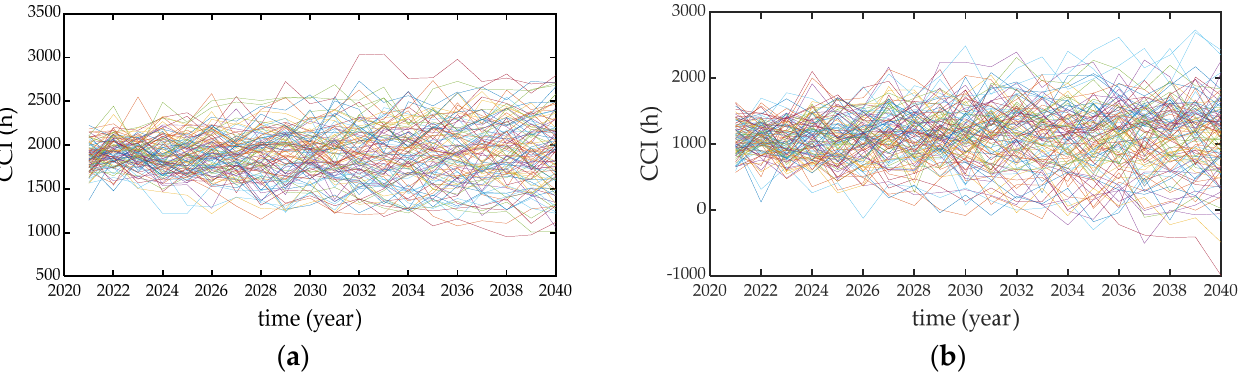
Figure 5. The scenes of the predicted CCIs of wind and solar power generation. ( a ) Predicted CCI of wind power generation; ( b ) Predicted CCI of solar power generation.